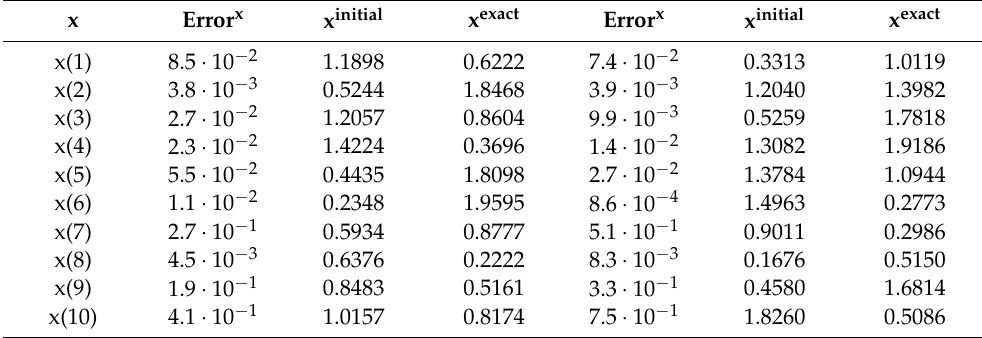
Table 4. Counterpart of Table 3 for the case in which the temperatures T 1 puted along with the degradations. The (randomly selected) values of the exact temperatures ) = ( 1345.5,1537.1 ) and ( T 1 are ( T 1 , T 2 4 t 4 t